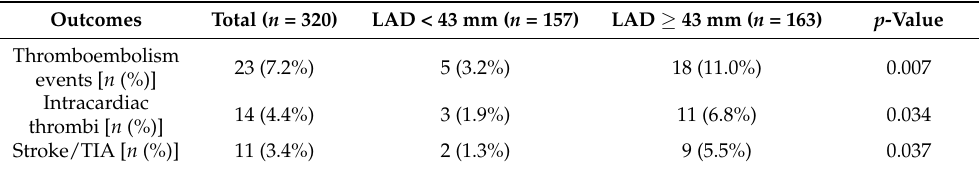
Table 2. Incidence of clinical events according to left atrial